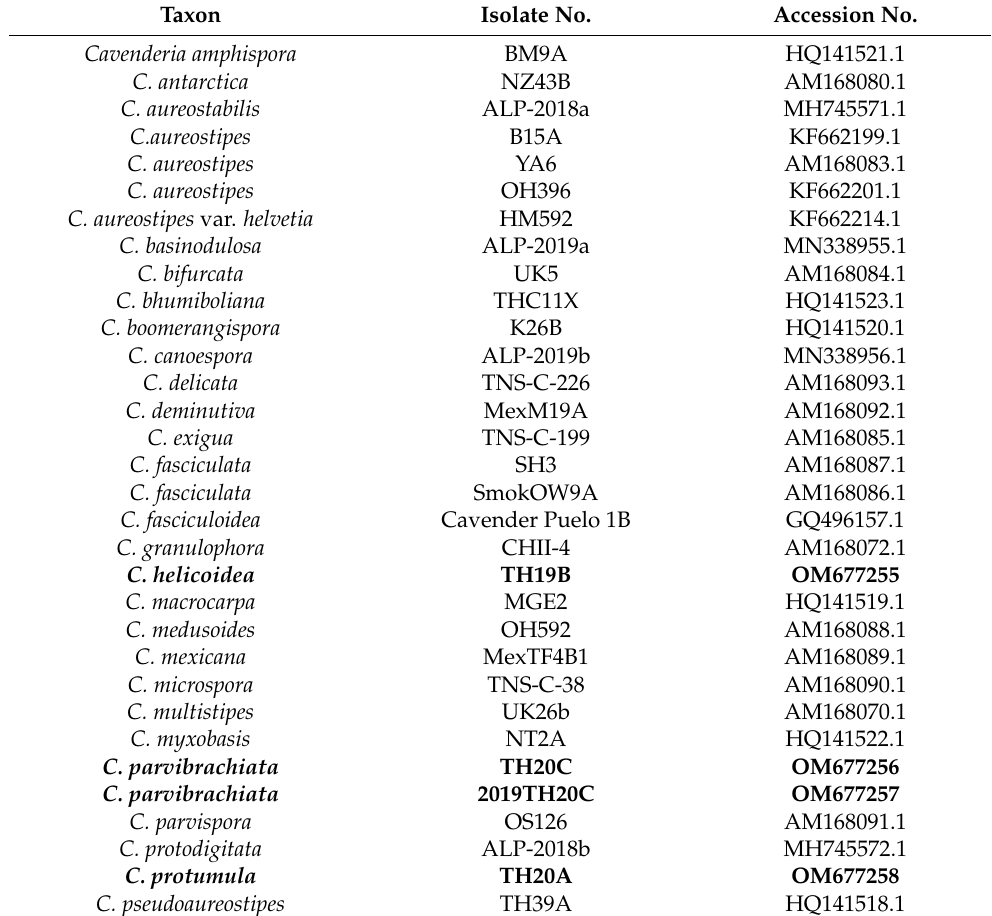
Table 1. NCBI GenBank accession information for SSU sequences of all isolates included in the phylogenetic analysis. New sequences are indicated in bold. Taxon Isolate No. Accession